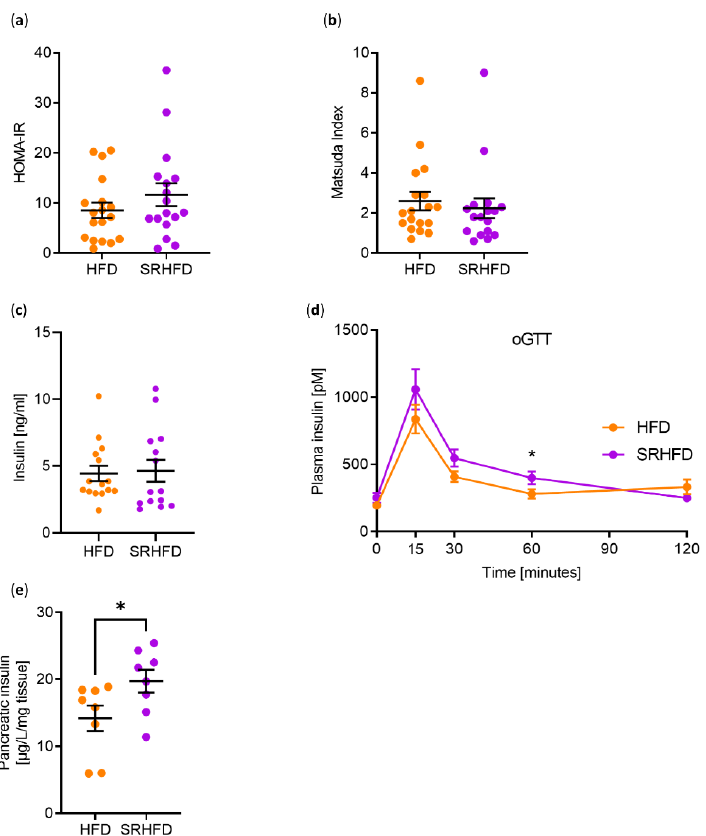
Figure 6. Selenite treatment in established obesity increases pancreatic insulin content. ( a ) Calcu-lated values for the homeostatic model assessment of insulin resistance HOMA-IR using data from the oGTT of male C57BL/6N mice fed either HFD or SRHFD for 8 weeks after established obesity. ( b ) Calculated values for the Matsuda insulin sensitivity index using data from the oGTT of male C57BL/6N mice fed either HFD or SRHFD for 8 weeks after established obesity. ( c ) Plasma insulin levels of male C57BL/6N mice fed either HFD or SRHFD for 10 weeks after established obesity. ( d ) Plasma insulin levels during the oGTT of male C57BL/6N mice fed either HFD or SRHFD for 8 weeks after established obesity. ( e ) Pancreatic insulin levels of male C57BL/6N mice fed either HFD or SRHFD for 10 weeks after established obesity. *: p < 0.05 after two- tailed Student’s t -test. All data are presented as mean ± SEM.